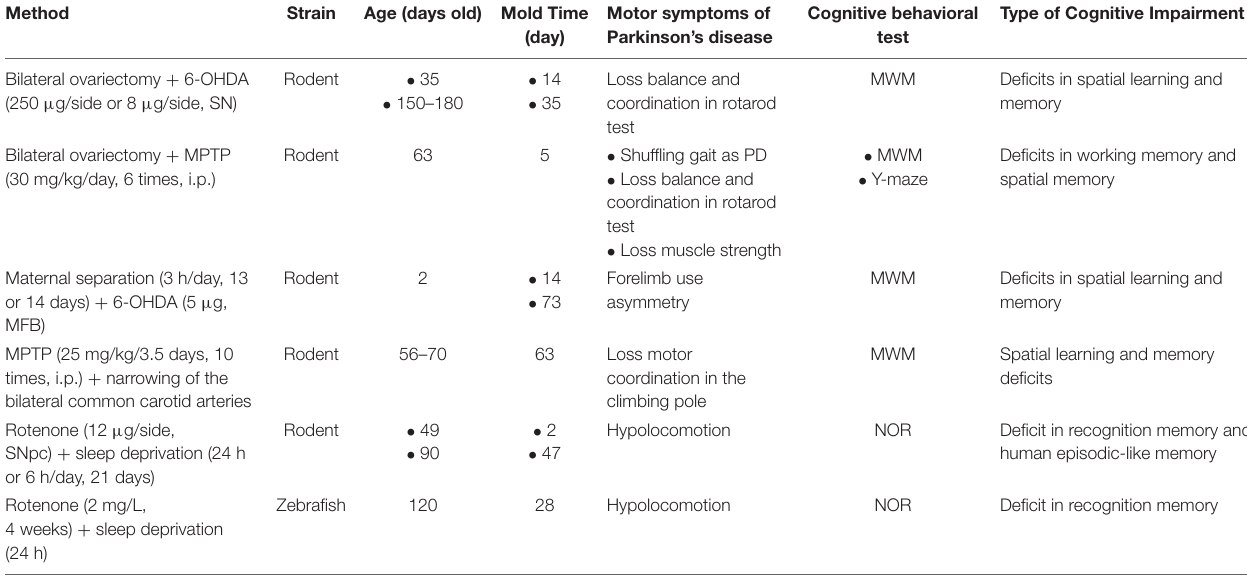
TABLE 8 | Methods of models combining toxin and surgery.